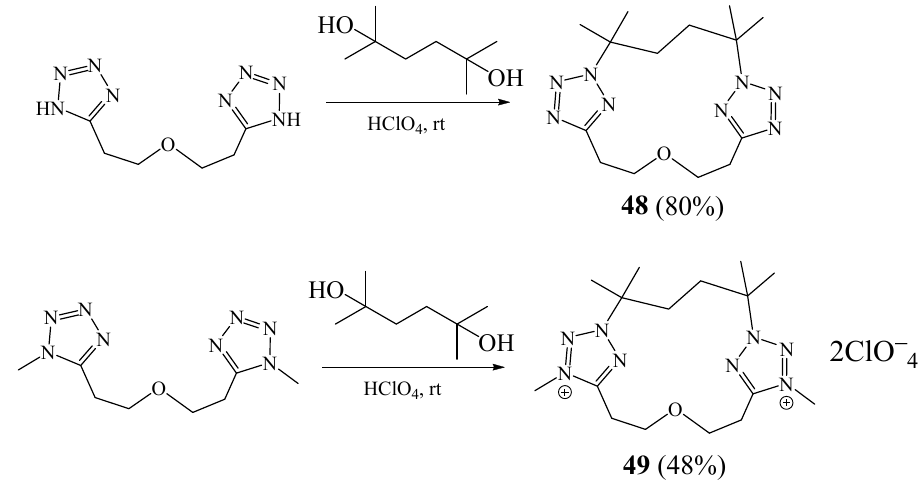
Figure 14. Monetetrazole containing macrocycles 44 − 47.